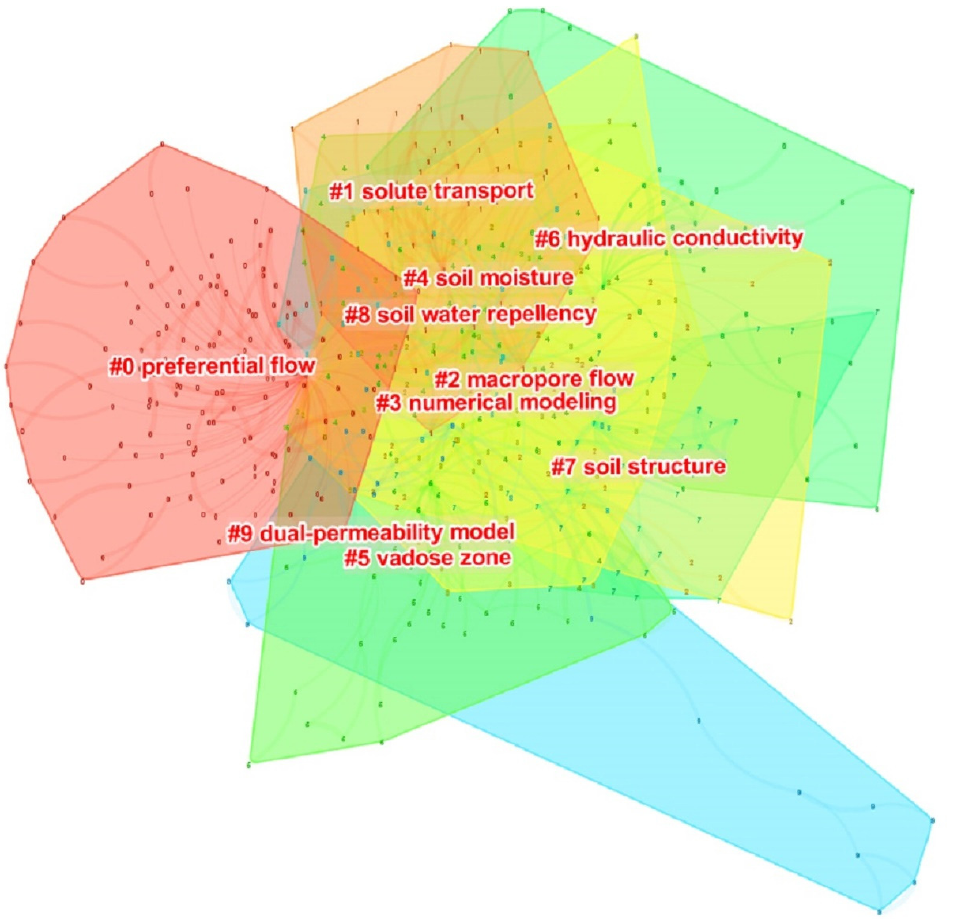
Figure 4. Cluster analysis of keywords from WoS database.